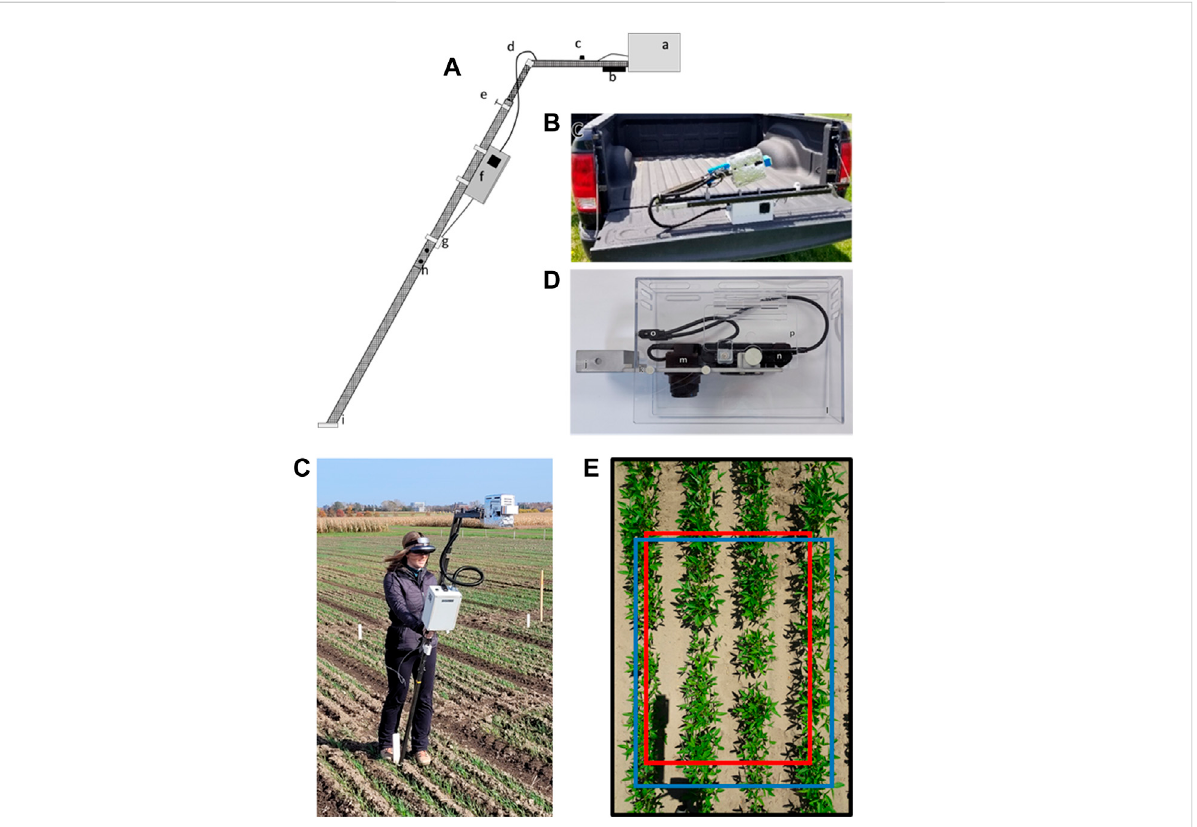
FIGURE 1 (A) , Schematic of the PlotCam: a) camera head, b) depth camera, c) pyronometer, d) cabling, e) compression fi tting adjustable telescopic pole, f) instrument box, g) temperature sensor, h) joint between upper and lower unipod segments, i) foot mounted at 60 o ; (B) , image of PlotCam folded for transport; (C) , Image of operator holding the camera in the fi eld showing the headset and battery belt; (D) , Camera head without heat shield covering: j) mountingbracket,k)cameramountingplate,l)plexiglassprotectivehousing,m)infraredcamera,n)visiblecamera,o)internalUSBcablestoexternal ports, p)accessdoor, (E) Overlay ofthe fi eldsofview of theRGBcamera (black border, 255 cm× 175 cmdimensionson theground), depthcamera(blue border, 187 cm; 135 cm), and infrared camera (red border, 170 cm × 118 cm) at a PlotCam height of 184 cm.